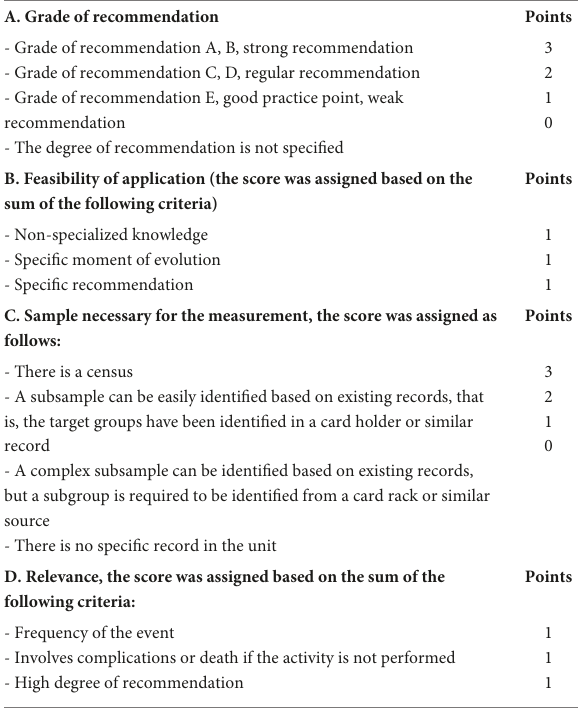
TABLE 1 Scoring system used to build the recommendation prioritization